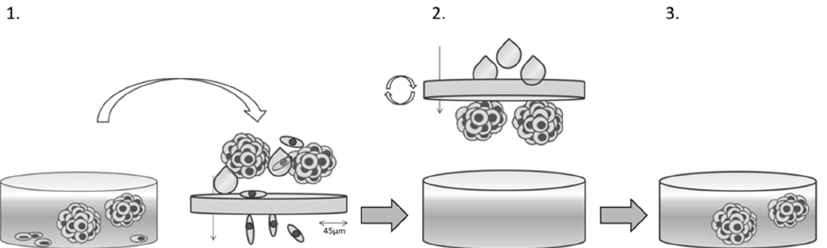
Figure 7. Spheroid formation assay. Cells are cultured in stem cell medium on ultra-low attachment plates. After their respective incubation periods, cultures are filtered over a 45 µmol/L cell filter. Single cells pass through the filter. Cells which are part of a very dense cell cluster that cannot be separated through mechanical means are called spheroids. Spheroids are held back in the retentate. The retentate is then resuspended in stem cell medium and is ready for treatment.